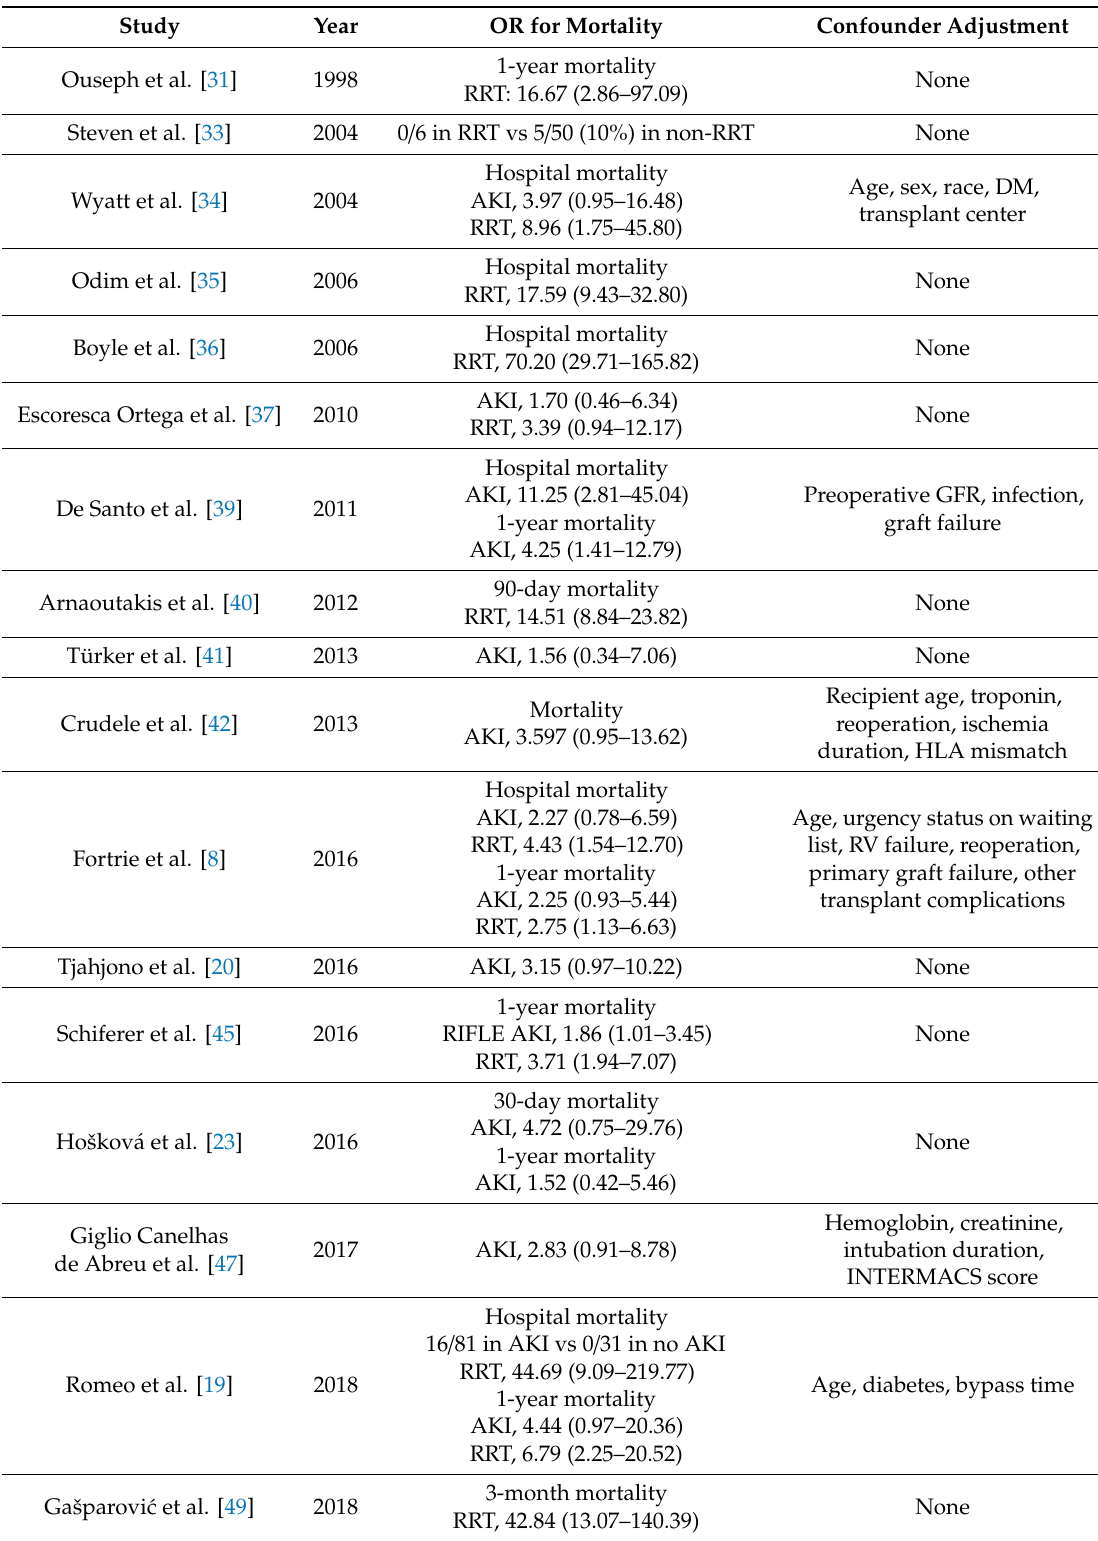
Table 2. Included studies in this analysis of AKI associated mortality risk in patients undergoing cardiac